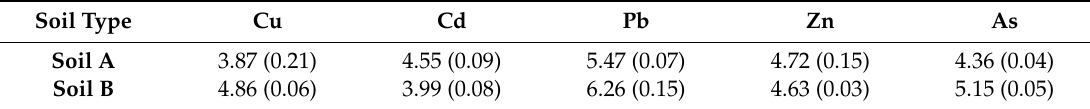
Table 2. Average value of heavy metal and metalloid (HM) partition coe ffi cients (log K d ; L / Kg). The standard deviations are listed in the